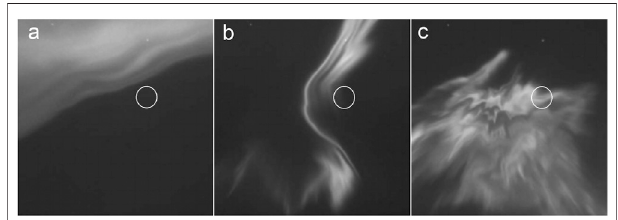
FIGURE 9 | Adapted from Semeter et al. (2008) and Akbari et al. (2012): Auroral morphologies recorded by a high-speed, high-resolution optical imager when coherent echoes appeared in the Poker Flat incoherent scatter radar ’ s fi eld of view (represented by the white circles) on March 23, 2007. The auroral arcs in panels a and b consist of small-scale features, thought to be associated with dispersive-scale Alfvén waves, and are recorded at times when the radar detected LT echoes. The auroral morphology in panel c is different than those in panels (A) and (B) . At the time of this image, the radar detected a type of coherent echo known as the Naturally Enhanced Ion Acoustic